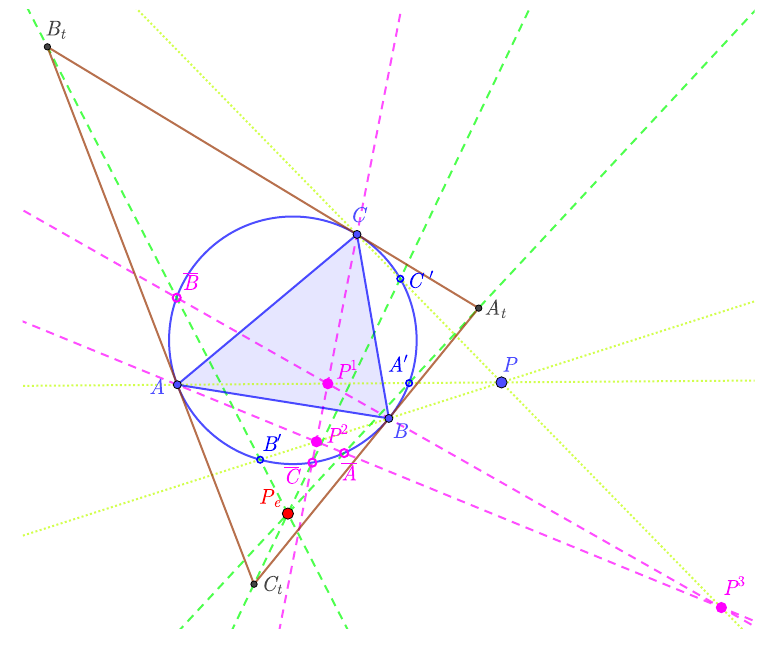
Figure 3. Four points ( P , P 1 , P 2 , and P 3 ) have the same image P e